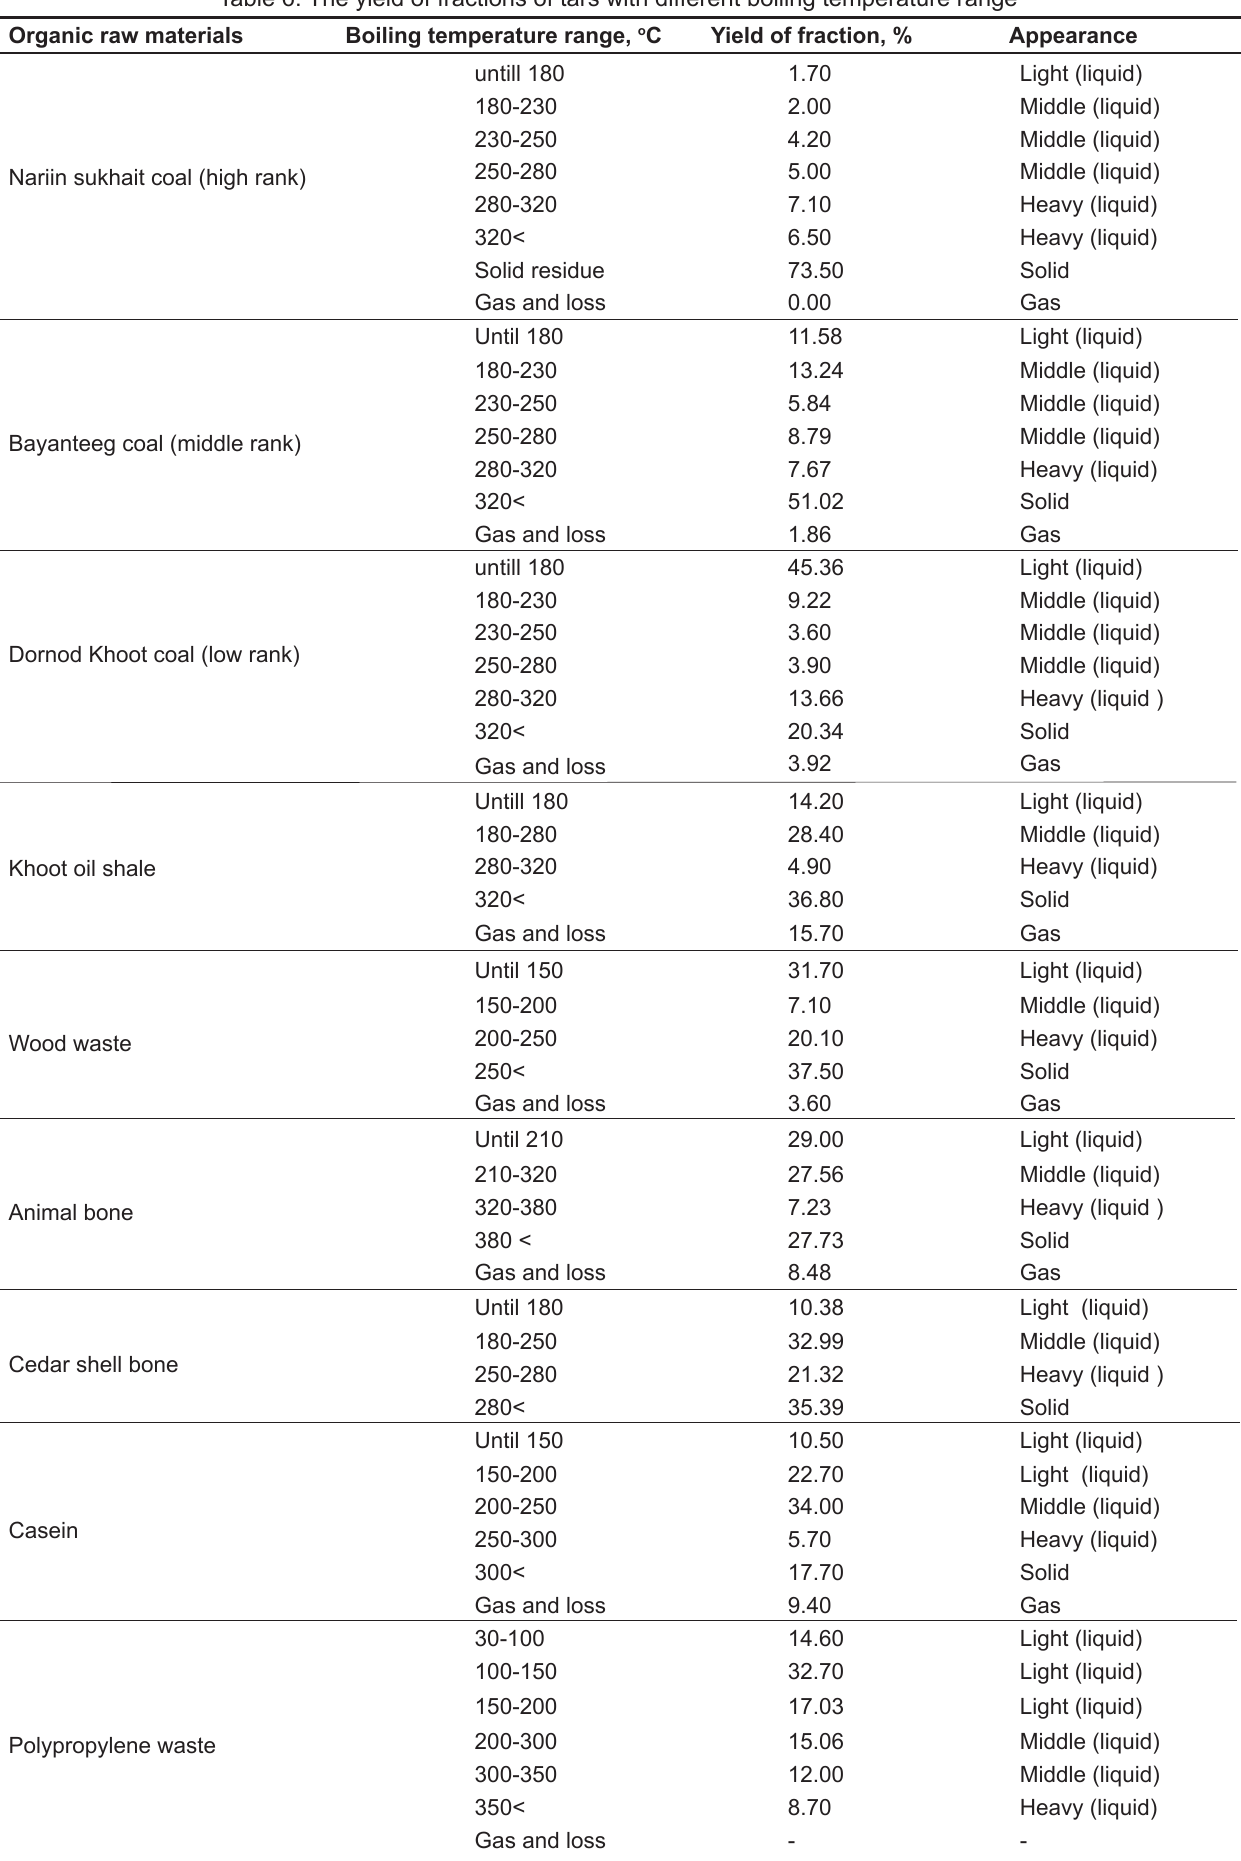
Table 6. The yield of fractions of tars with different boiling temperature range Organic raw